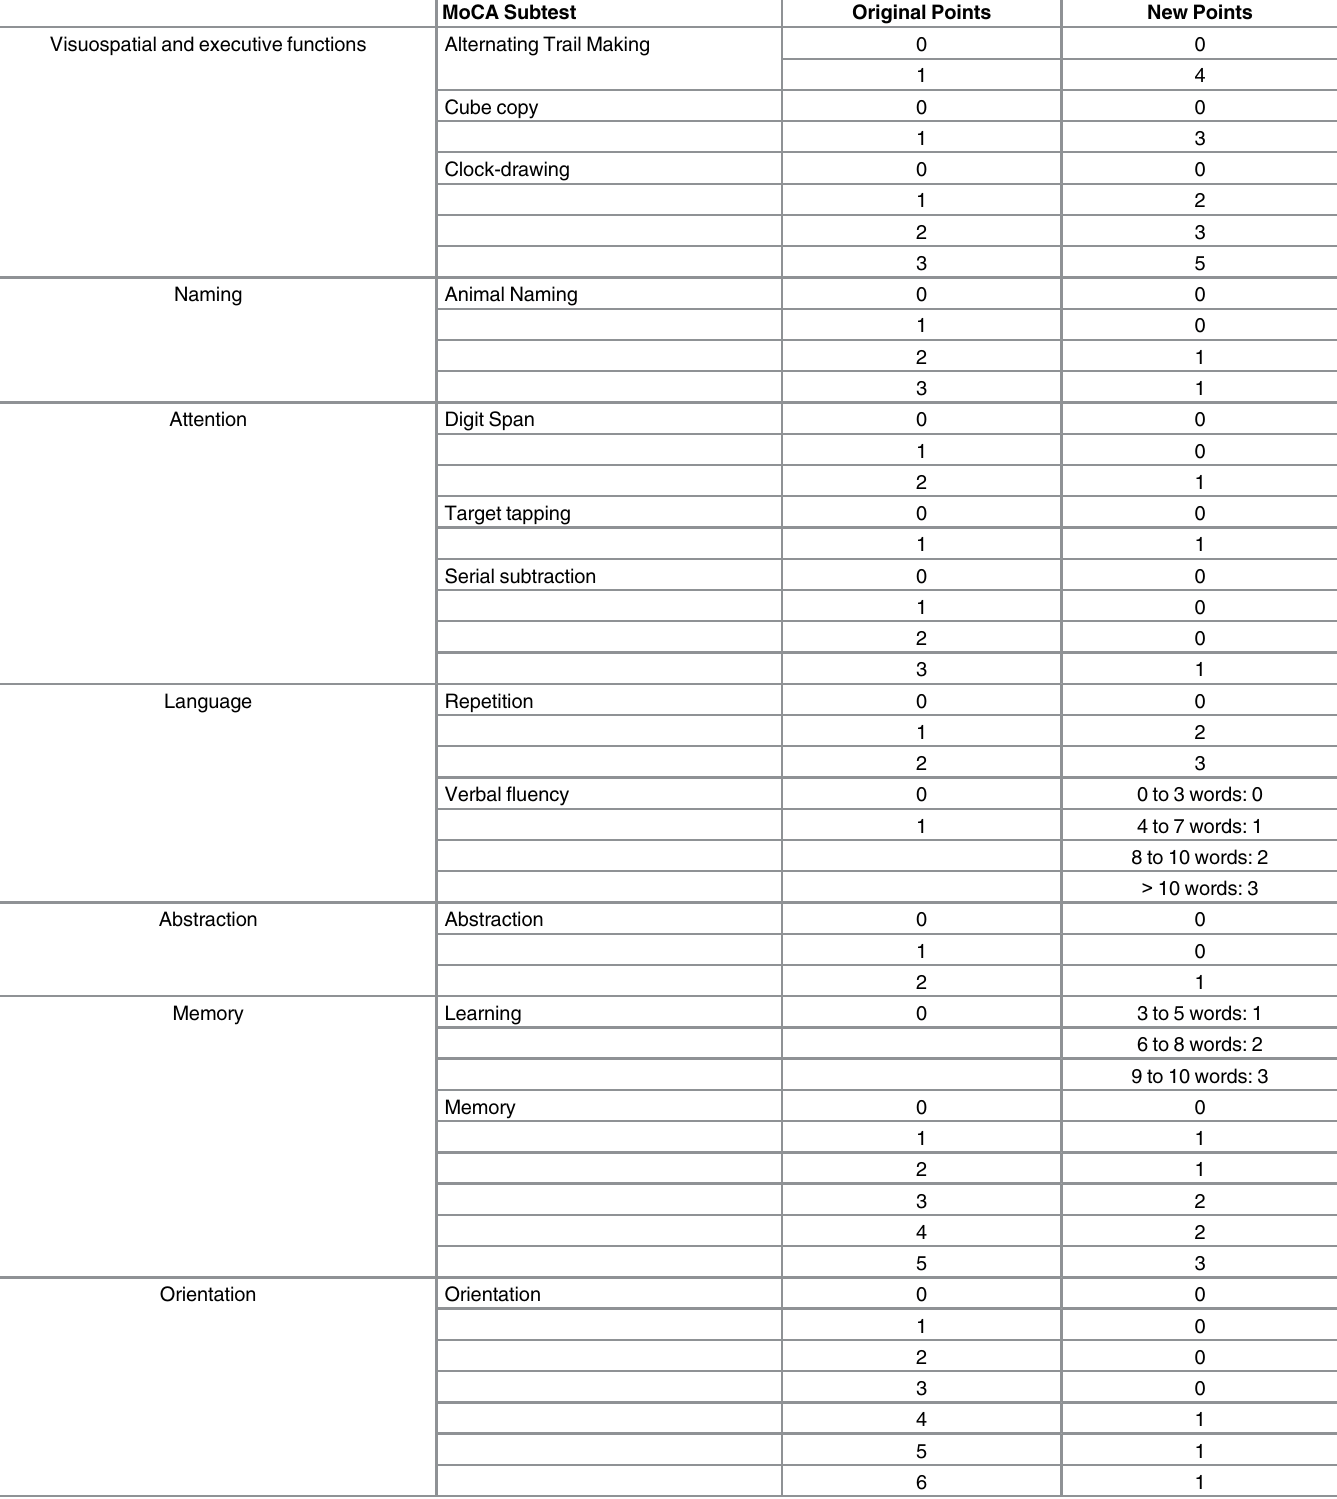
Table 2. Conversion table for scoring of the MoCA